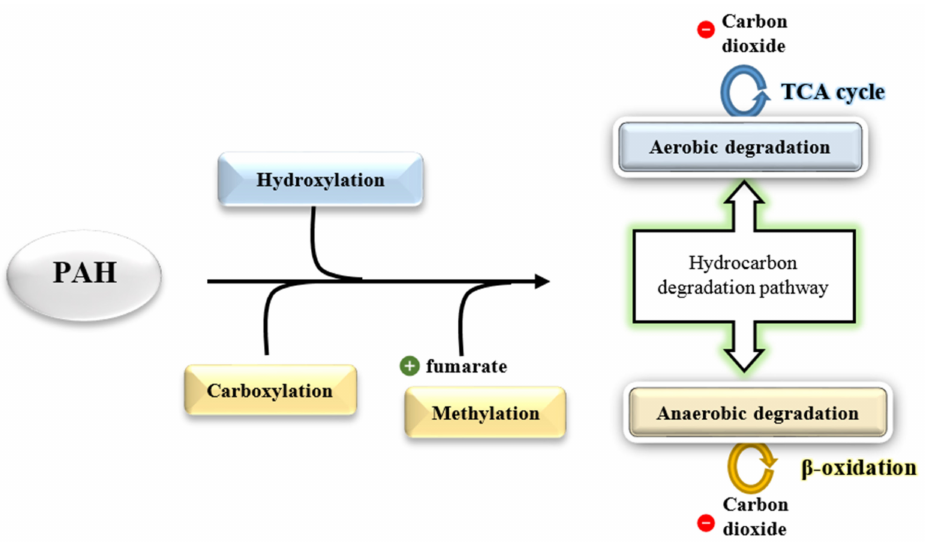
Figure 8. The primary activation mechanism in PAH degradation via the initial step of activation (reconstructed from [34] through adaption from